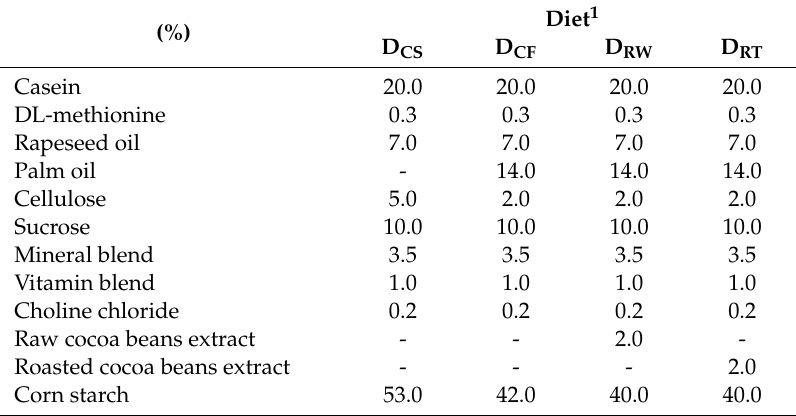
Table 2. Composition of the group-specific